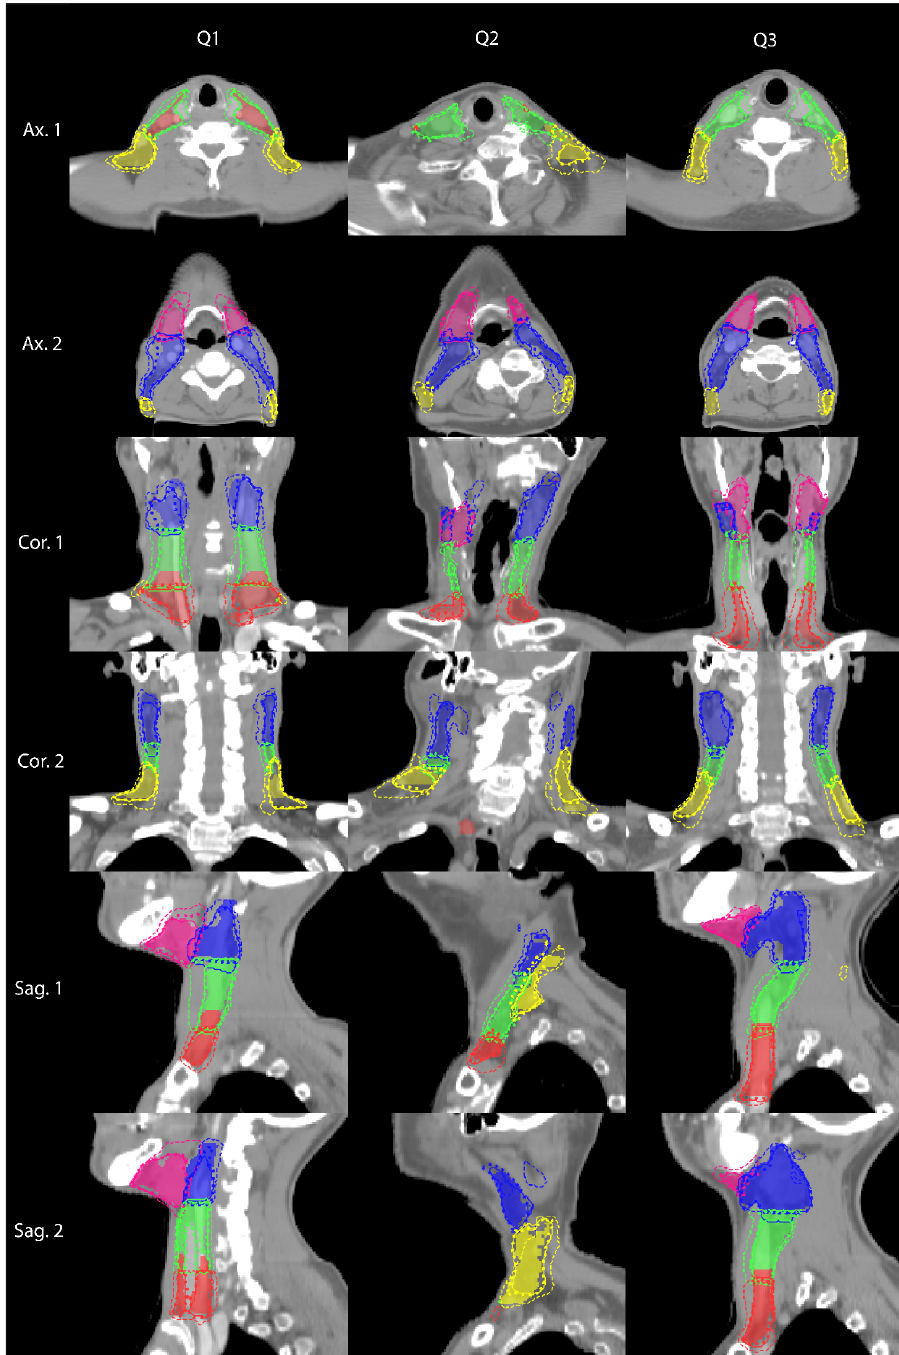
Figure 3. Example segmentations selected from the first (Q1), second (Q2) and third (Q3) quartile in terms of DSC averaged over individual LN levels I – V. The filled region is the manual reference. The solid, dashed and dotted lines correspond to the predictions of the model configurations of UNet, MV and UNet+MV, respectively. LN levels I – V are indicated in pink, blue, green, red and yellow, respectively. The low average DSC in Q1 was in part attributed to an error in the manual reference level III – IV transition. Abbreviations: DSC: dice similarity coefficient; LN: lymph node.